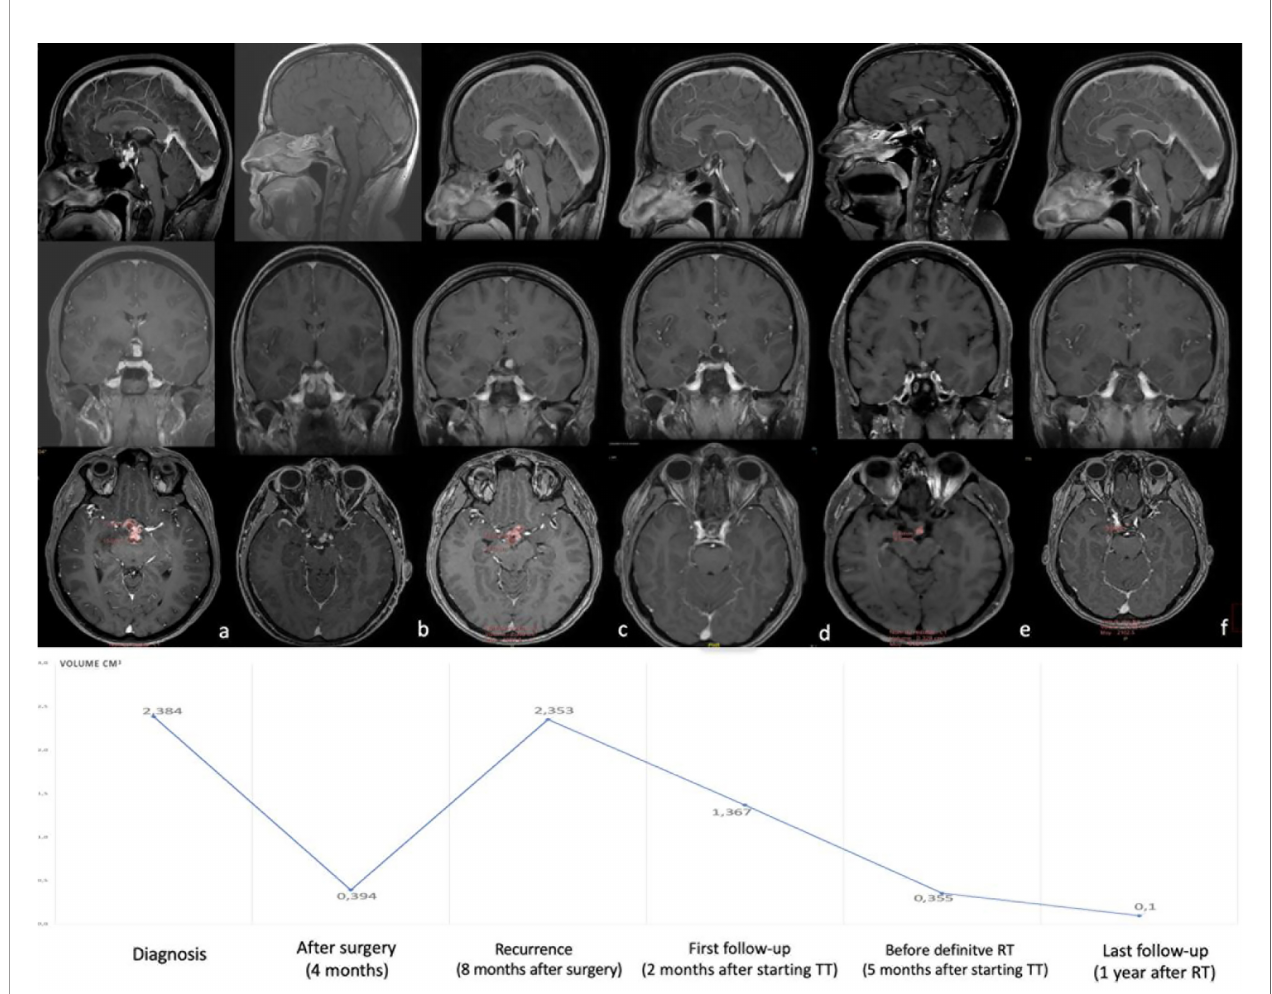
FIGURE 1 | Post-gadolinium axial, coronal and sagittal T1WI MRI images, representing the clinical course in case 1. (A, B) Shows the tumor volume and presentation at time of diagnosis (25.4 x 15.0 mm maximal axis and 2.384 cm3 volume) and after surgery (maximal axis: 7.5 x 11.5 mm, volume: 0.394 cm3). (C) Shows tumor recurrence/regrowth at 12 months postoperatively (13 x 24 mm and a volume of 2.353 cm3). (D, E) Show dramatic and rapid reduction in tumor volume at 2 months (80 %) and 4 months (90%) after starting combined anti-BRAF/MEK therapy. (F) Shows results at 1 year after fi nal radiotherapy (near complete response). Volume curve has been reported in the inferior part of fi gure. TT: B-RAF and MEK inhibitor targeted therapy; RT: